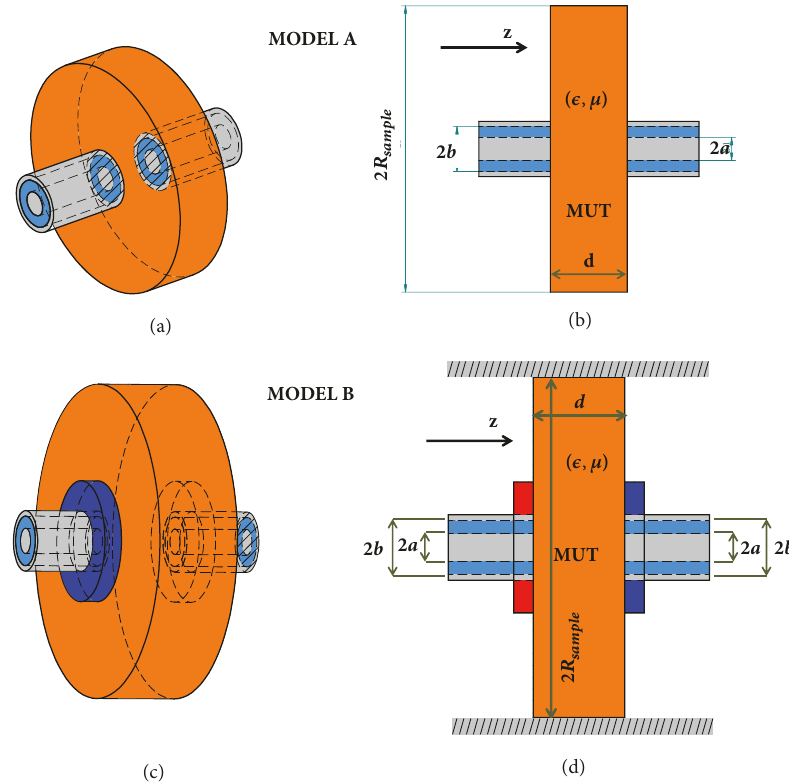
Figure3:Schematicproposedmodelsforthetwo-portcharacterization(additionaldetailswillbegiveninFigures6and14).ModelA:circular waveguide with material sample within two coaxial lines: (a) 3D view; (b) longitudinal cut with dimensions defining the problem. Model B taking the flange into account: (c) 3D view; (d) longitudinal cut with main dimensions.